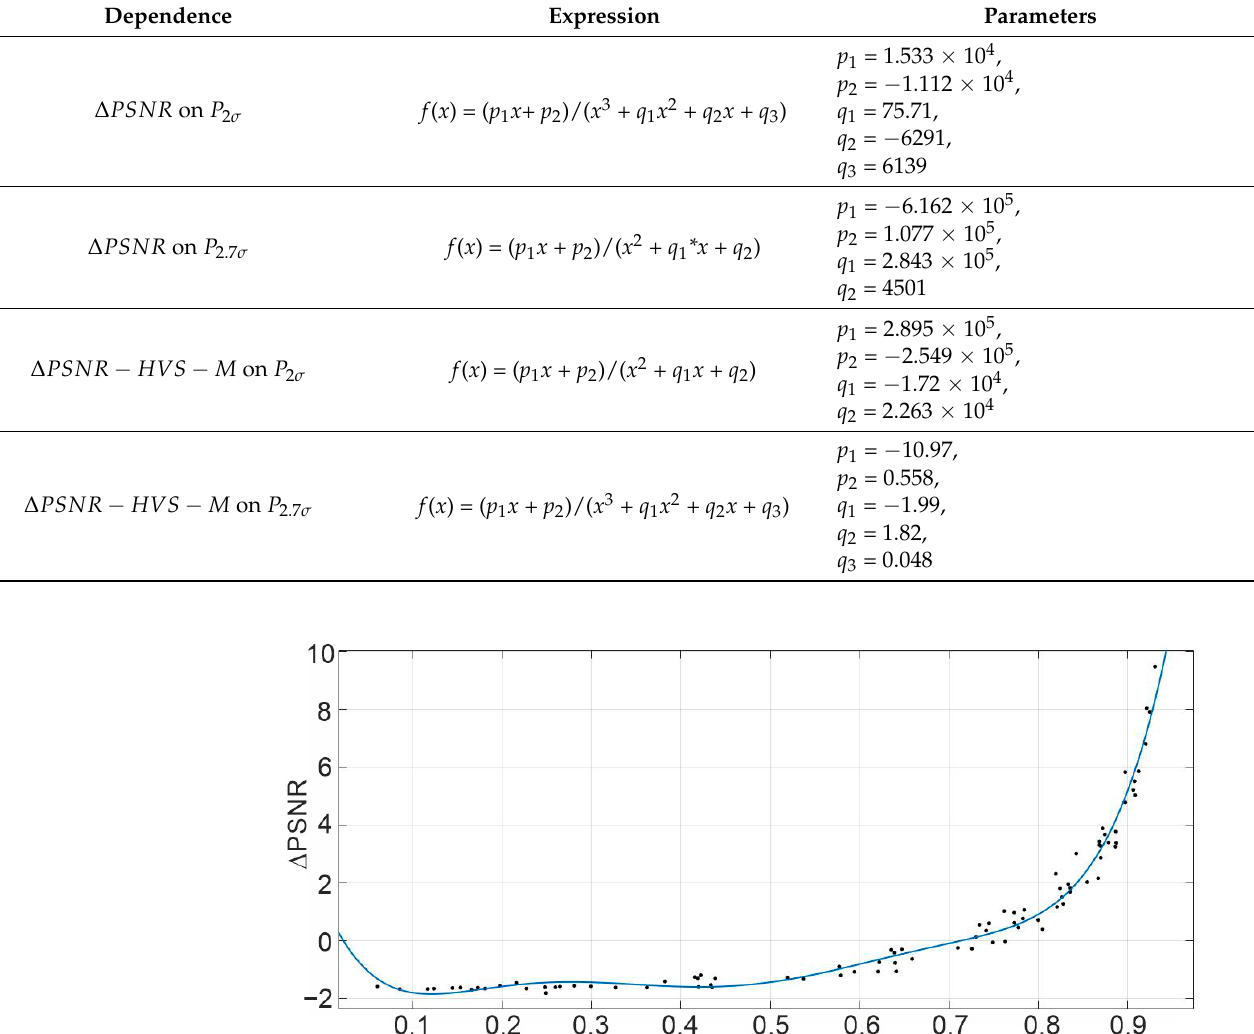
Table 1. Parameters of the fitted curves.